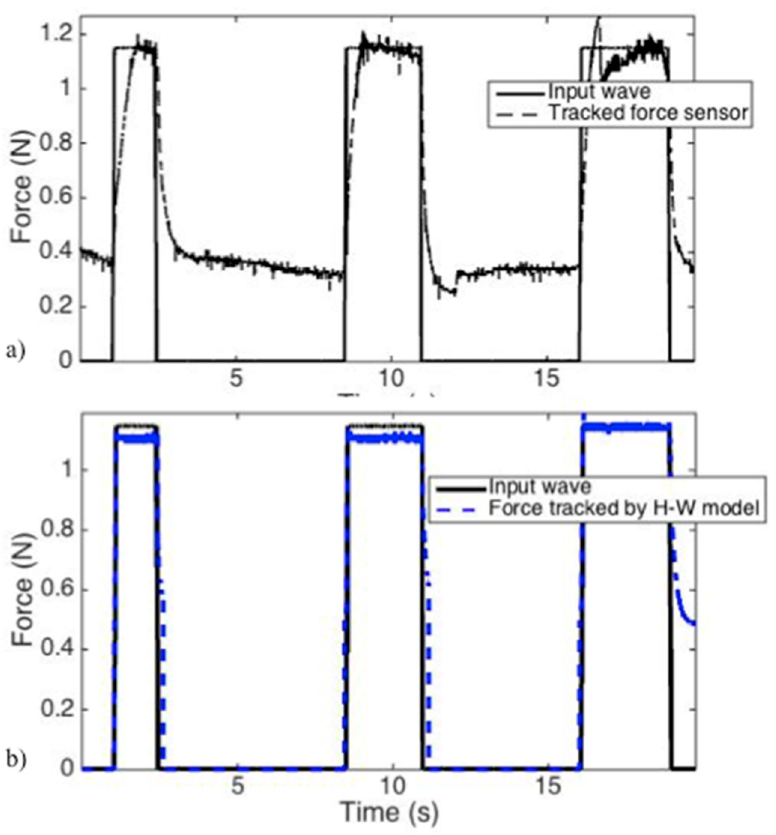
Figure 13. Multistep input with ( a ) a force sensor and ( b ) H-W modeling.